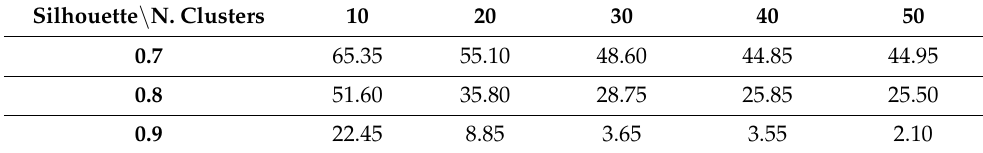
Table 33. Clustering performance in terms of silhouettes using the reduced dataset with SPQR. Silhouette \ N. Clusters